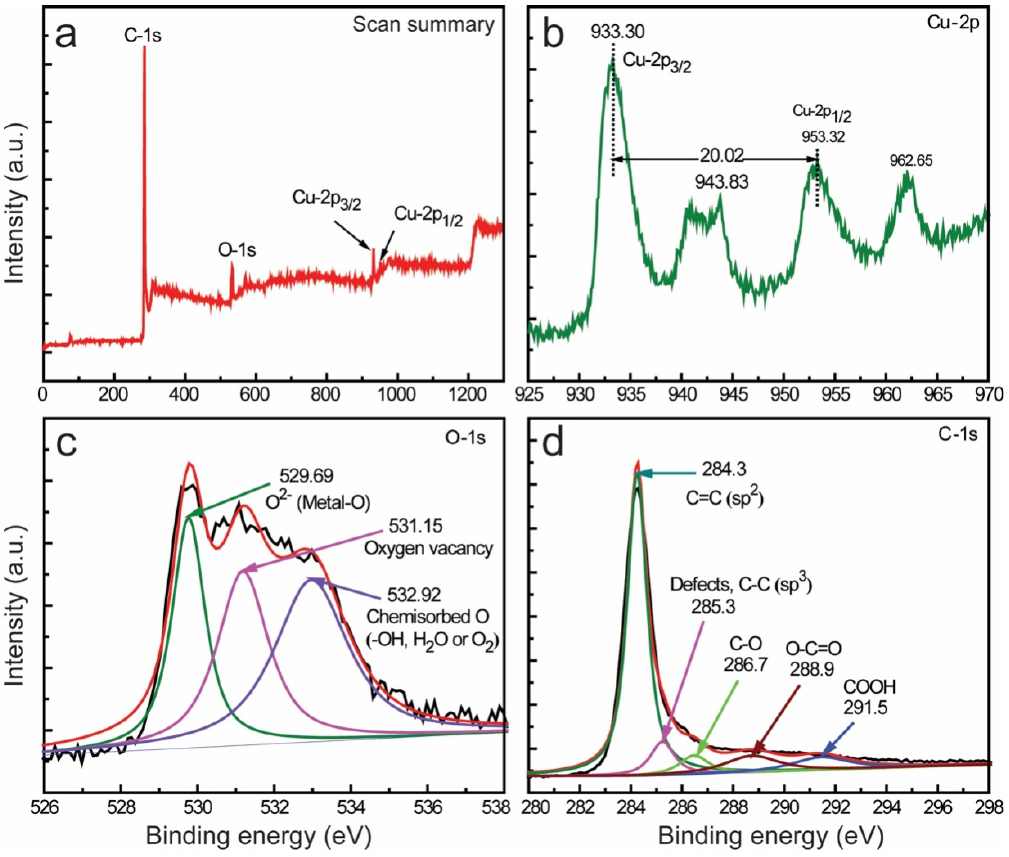
Figure 4. XPS spectra of the composites: ( a ) survey spectra of the synthesized CuO-SWCNT-5 nanocomposite, and high-resolution spectra displaying ( b ) Cu-2 p scan demonstrating Cu-2 p 3/2 and Cu-2 p 1/2 peaks, ( c ) the core level of O 1 s , and ( d ) the core level of C 1 s in the CuO-SWCNT-5 nanocomposite.